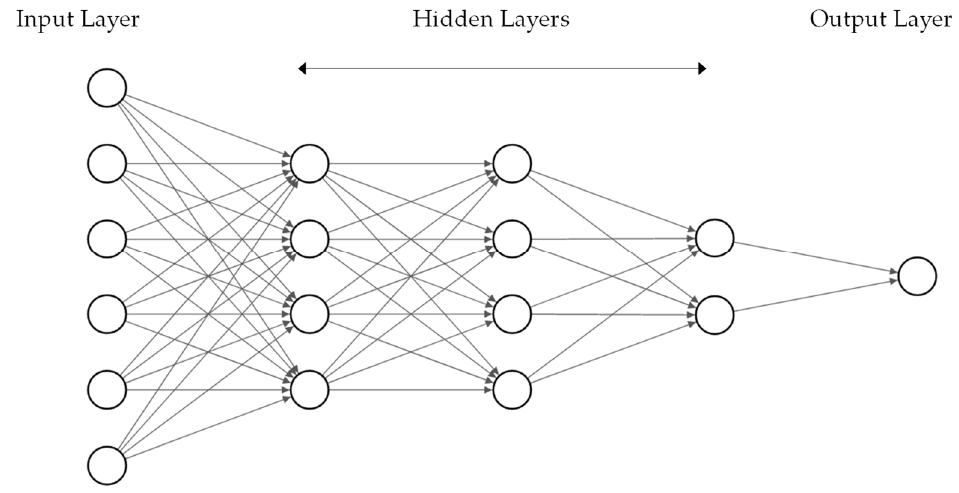
Figure 1. Feedforward neural network with sic nodes in the input layer, three hidden layers and one node in the output layer.